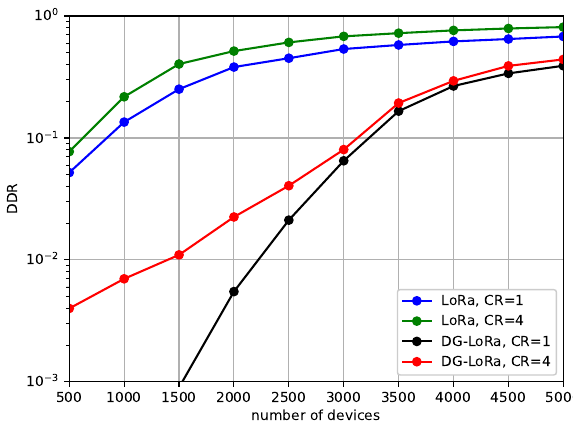
Figure 9. Data drop rate according to the coding